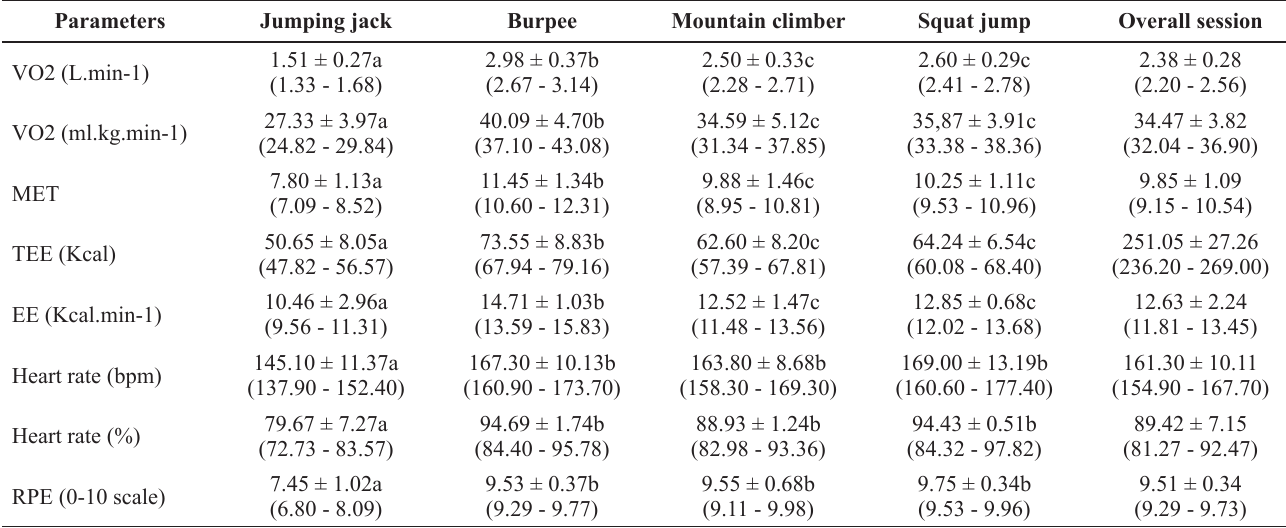
Table 1 - Physiological responses of HIIT body work®